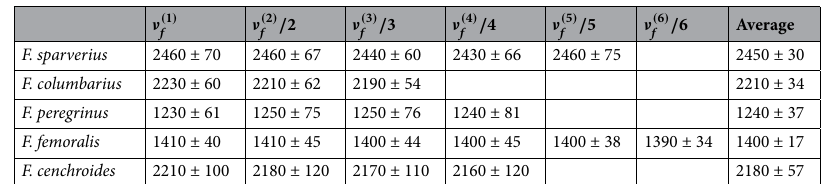
( n ) / n (in Hz) for each species. Errors are 95% f